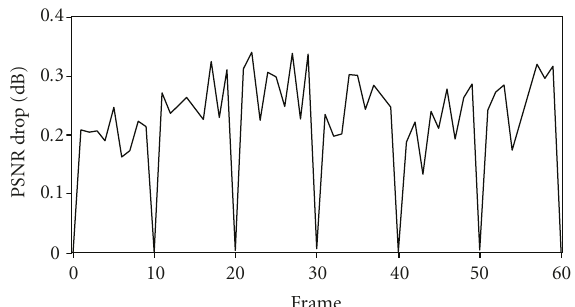
Figure 15: PSNR di ff erence between the original H.264 encoder and the integrated H.264 encoder with the proposed FMC.